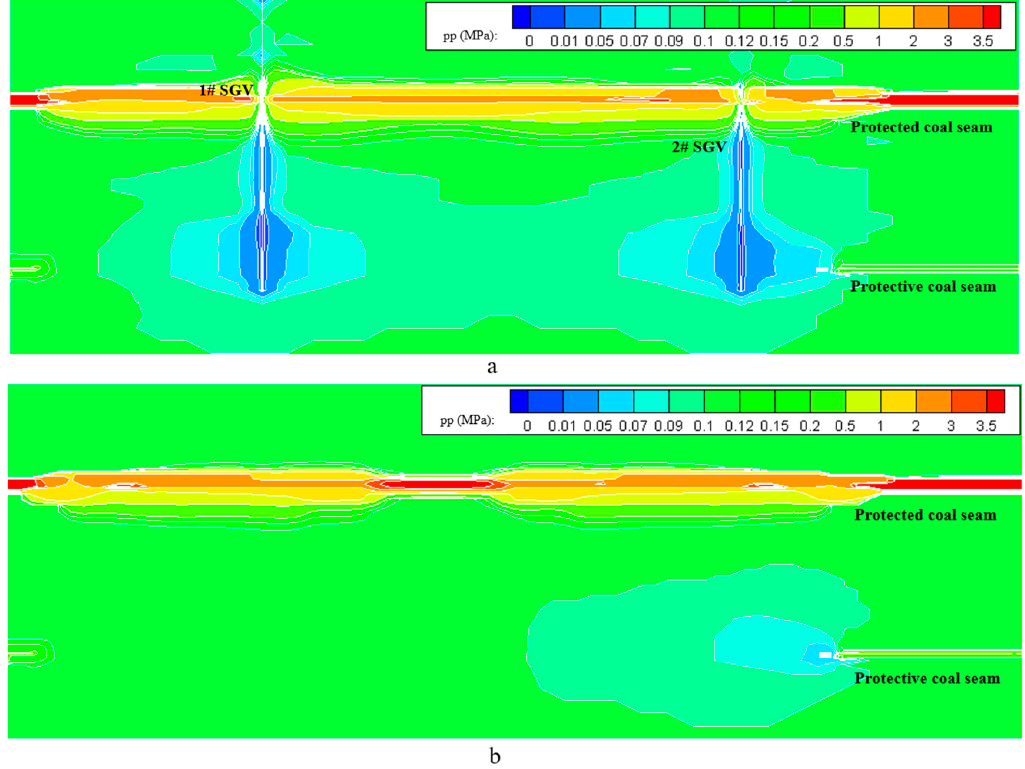
Figure 8. Gas pressure distribution, ( a ) and ( b ) is with and without SGV